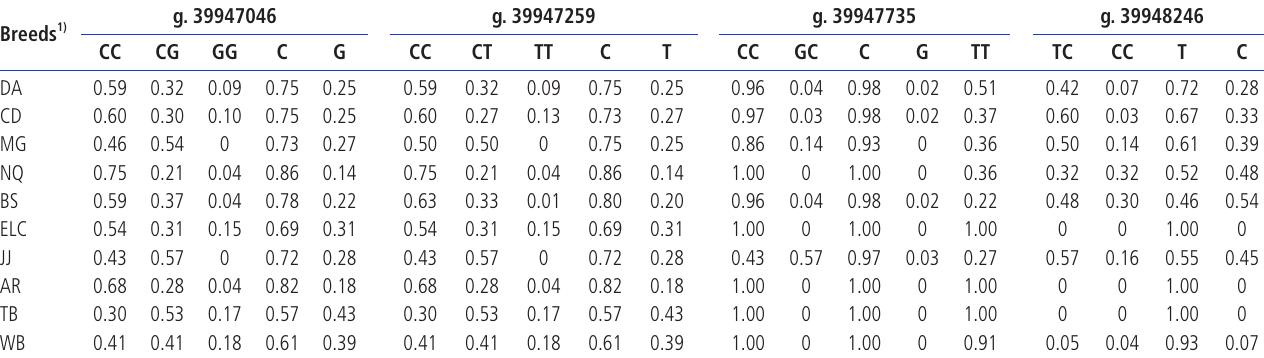
Table 3. The allele and genotype frequencies for the polymorphisms of eCG α gene in the studied breeds Breeds